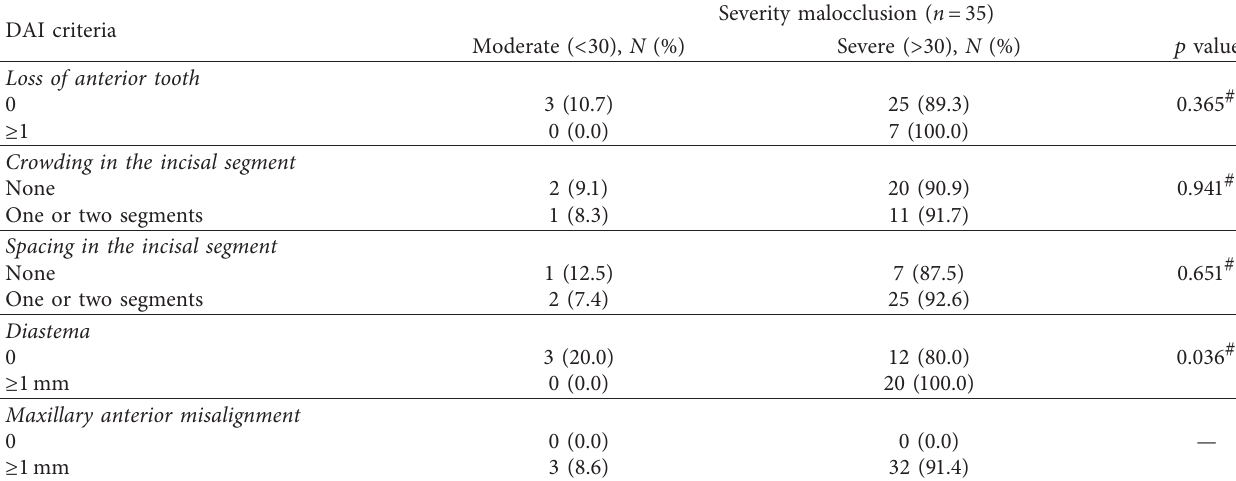
Table 4: Distribution of children and adolescents with CP according to DAI criteria and severity malocclusion in permanent dentition. DAI